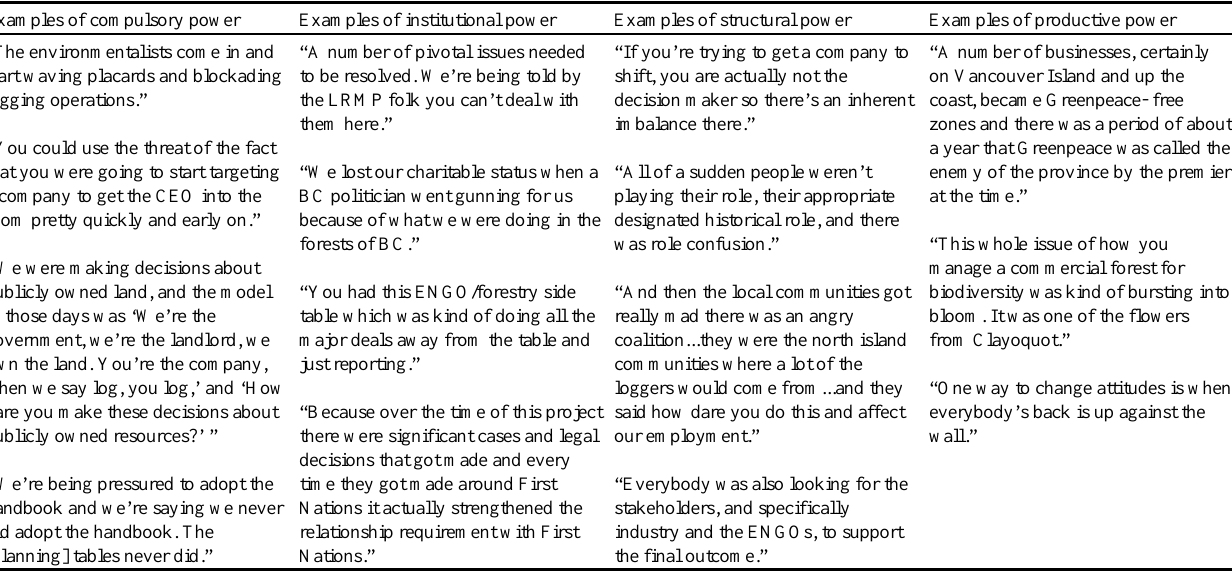
Table 1 . Sample of selected quotes coded to power framework. Examples are listed